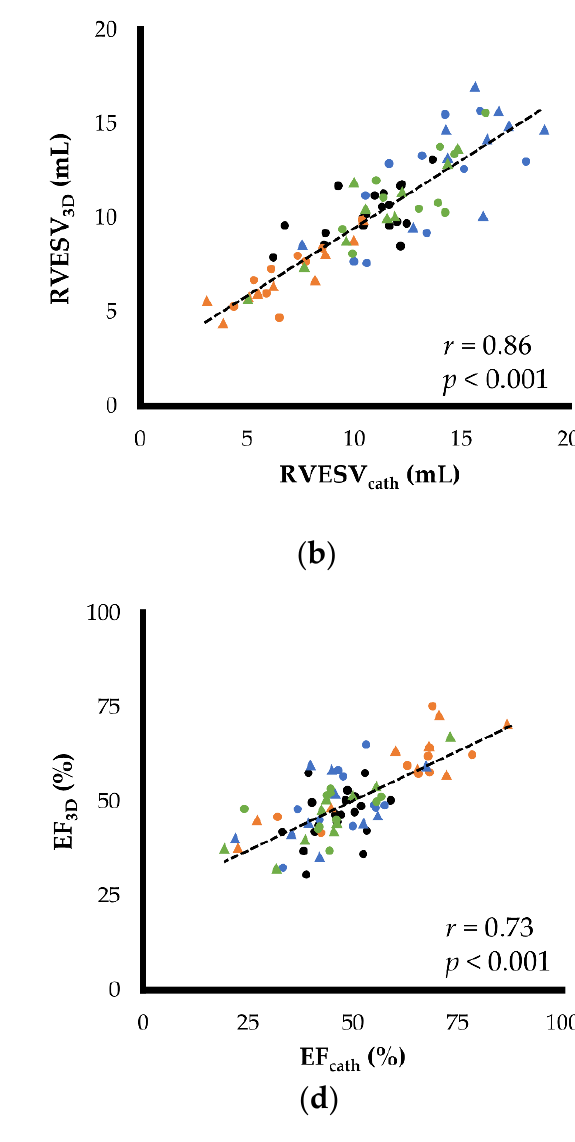
Figure 2. Correlations between the right ventricular morphology and function measured by right heart catheterization and real-time three-dimensional echocardiography: ( a ) end-diastolic right ventricular volume (RVEDV); ( b ) end-systolic right ventricular volume (RVESV); ( c ) stroke volume (SV); ( d ) ejection fraction (EF). Black round dots show the measurements of baseline. Orange round and triangular dots show the measurements of 5 and 10 µg/kg/min dobutamine infusions, respectively. Blue round and triangular dots show the measurements of 15 and 30 min after acute volume load, respectively. Green round and triangular dots show the measurements of 15 and 30 min after furosemide administration, respectively.